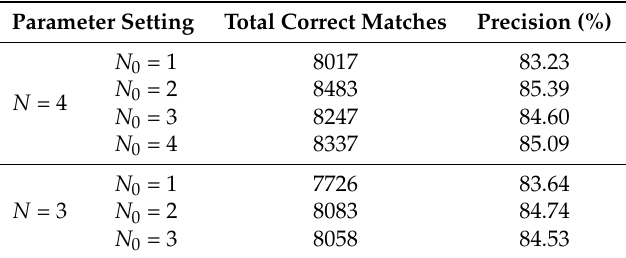
Table 3. Experimental Results with different parameters ( N , N 0 ).